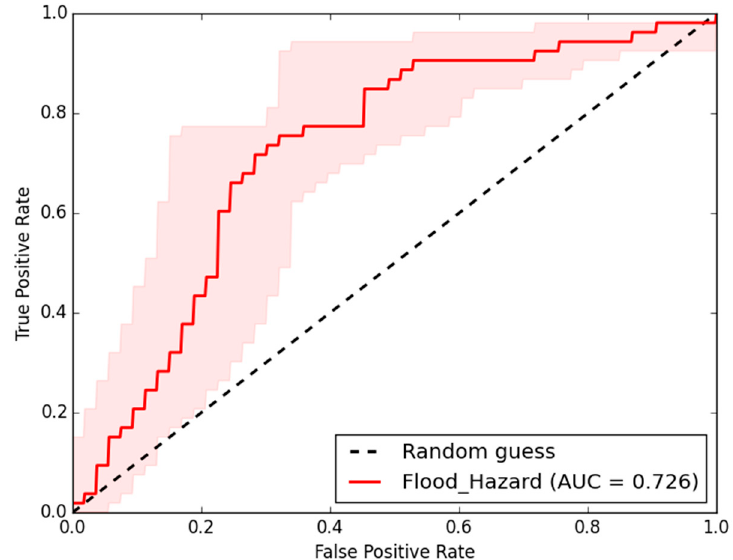
Figure 3. ROC curve for validating flood hazard layer .